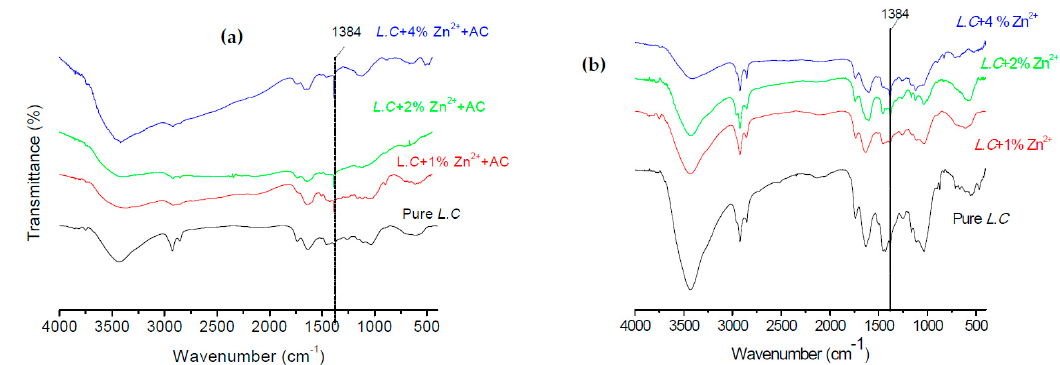
Figure 1. Spectrum of pure L.C and L.C + (1%, 2% and 4% Zn 2 + ) synthesized ( a ) in presence of alternating current (AC) and ( b ) in the absence of AC.